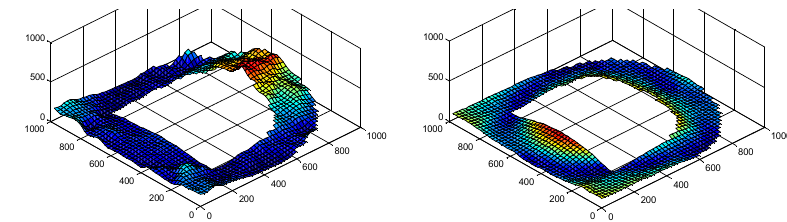
Figure 5. Comparison of the 3D Localization results ( R = 100m, M = 20%).